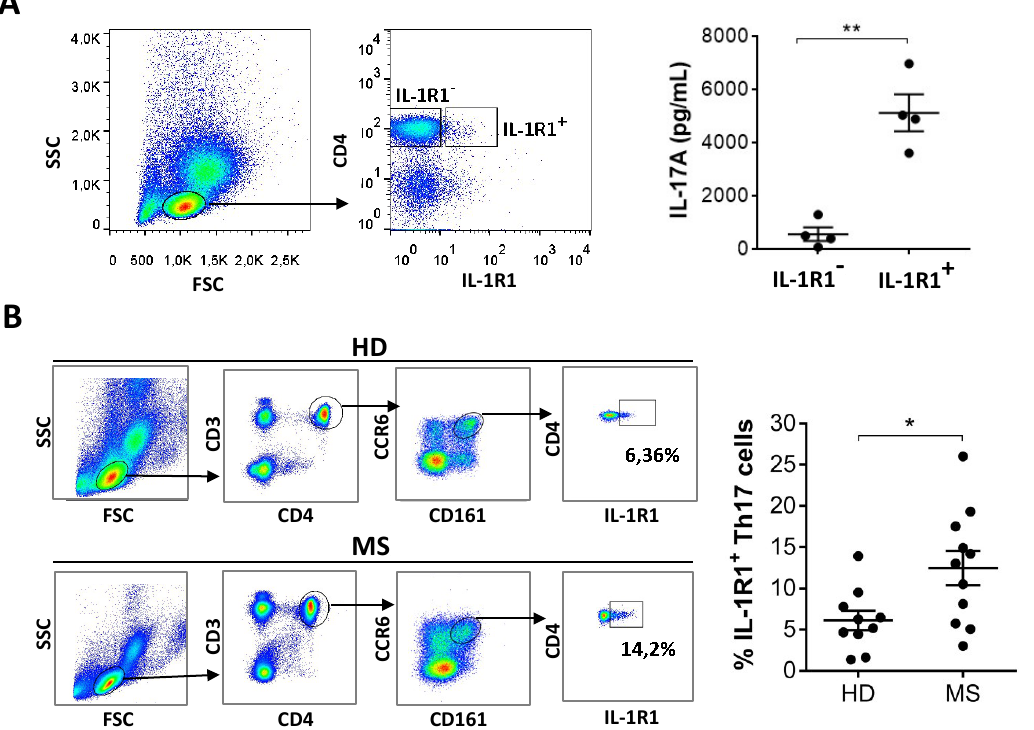
Figure 4. IL-1R1 + cells in the blood are Th17 cells and are increased in MS patients compared to healthy donors. Blood memory cells sorted as CD4 + IL-1R1 + and CD4 + IL-1R1 - cells (gating strategy in the left panel) were stimulated with antiCD3-antiCD28 for 24h. Supernatants were then analysed for IL-17 production by ELISA ( A ). Peripheral blood mononuclear cells from healthy donors (HD) and multiple sclerosis (MS) patients were stained with specific antibodies to analyse the frequency of CD3 + CD4 + CCR6 + CD161 + IL-1R1 + cells by flow cytometry ( B ). Graphs represent the results of independent experiments. (* p < 0.05; ** p < 0.01).